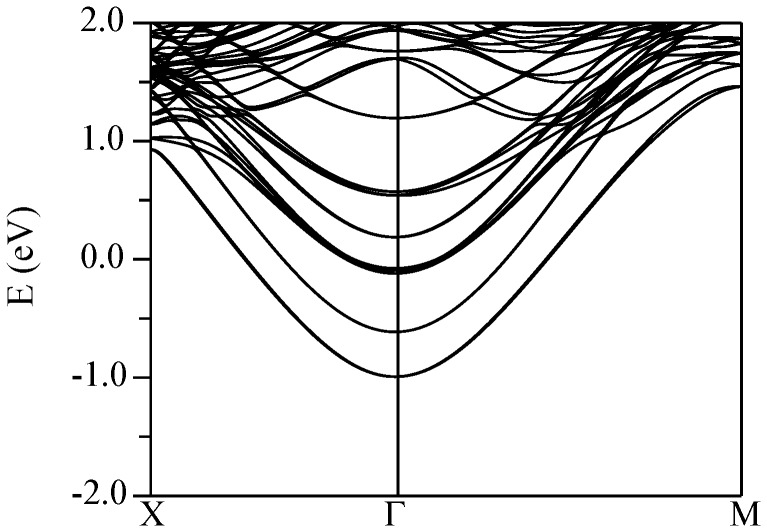
Calculated conduction band structure of the relaxed (KTaO3)//(ZnSnO3) supercell (see text) using the TB-mBJ potential.The Fermi energy is at 0 eV. Spin orbit is included.